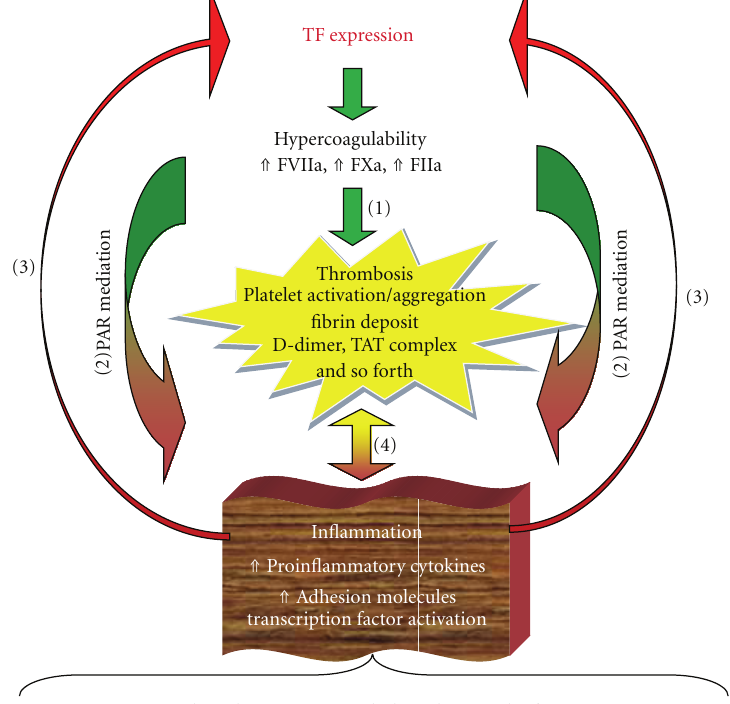
Figure 3: Coagulation-inflammation-thrombosis circuit. TF hypercoagulability results in direct thrombotic actions (1). TF also plays converging and diverging roles in driving the coagulation-inflammation cycle ((2) coagulation-dependent inflammation and (3) inflammation-dependent coagulation). Namely, TF hypercoagulability could result in enormous inflammation as the result of continuously refueling the cycle in which coagulation and inflammation promote each other upon the cycle gaining its initial momentum. Thrombosis- inflammation connection (4) is incorporated into the coagulation-inflammation cycle to form a complete coagulation-inflammation- thrombosis circuit, which manifests diverse pathological conditions in relation to inflammation and thrombosis, including cancers, APS, cardiovascular dysfunctions, diabetes, obesity, and